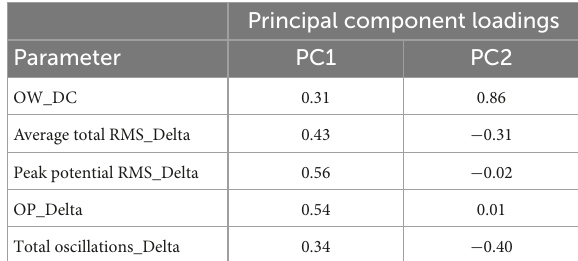
TABLE 2 Principal component loadings for PCA using effective parameter set for detecting the drug responses in human primary astrocytes.